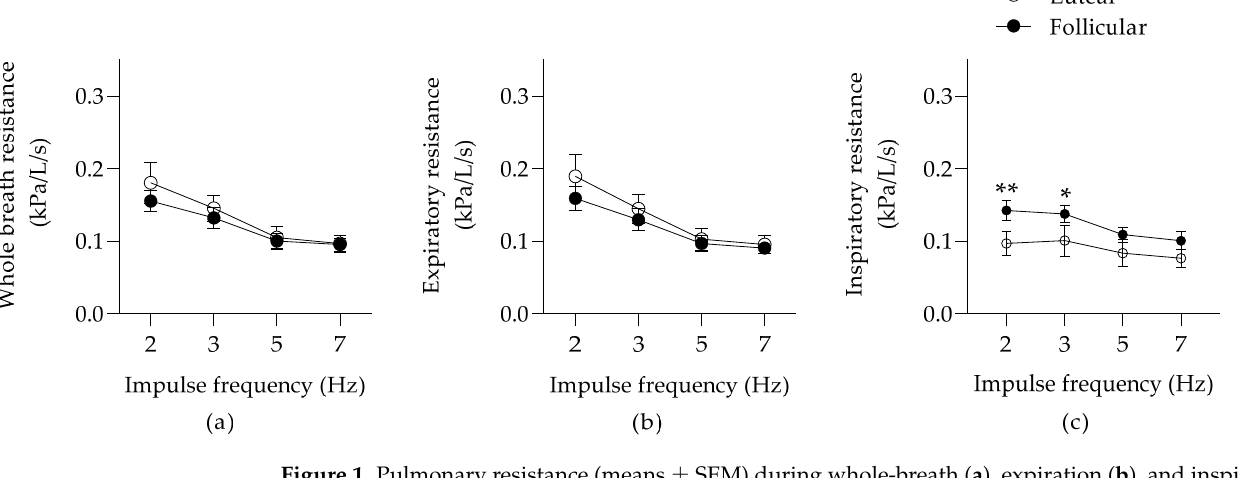
Figure 1. Pulmonary resistance (means ± SEM) during whole-breath ( a ), expiration ( b ), and inspiration ( c ). * p < 0.05 and ** p < 0.01 between the estrus phases with Bonferroni’s multiple comparison tests.